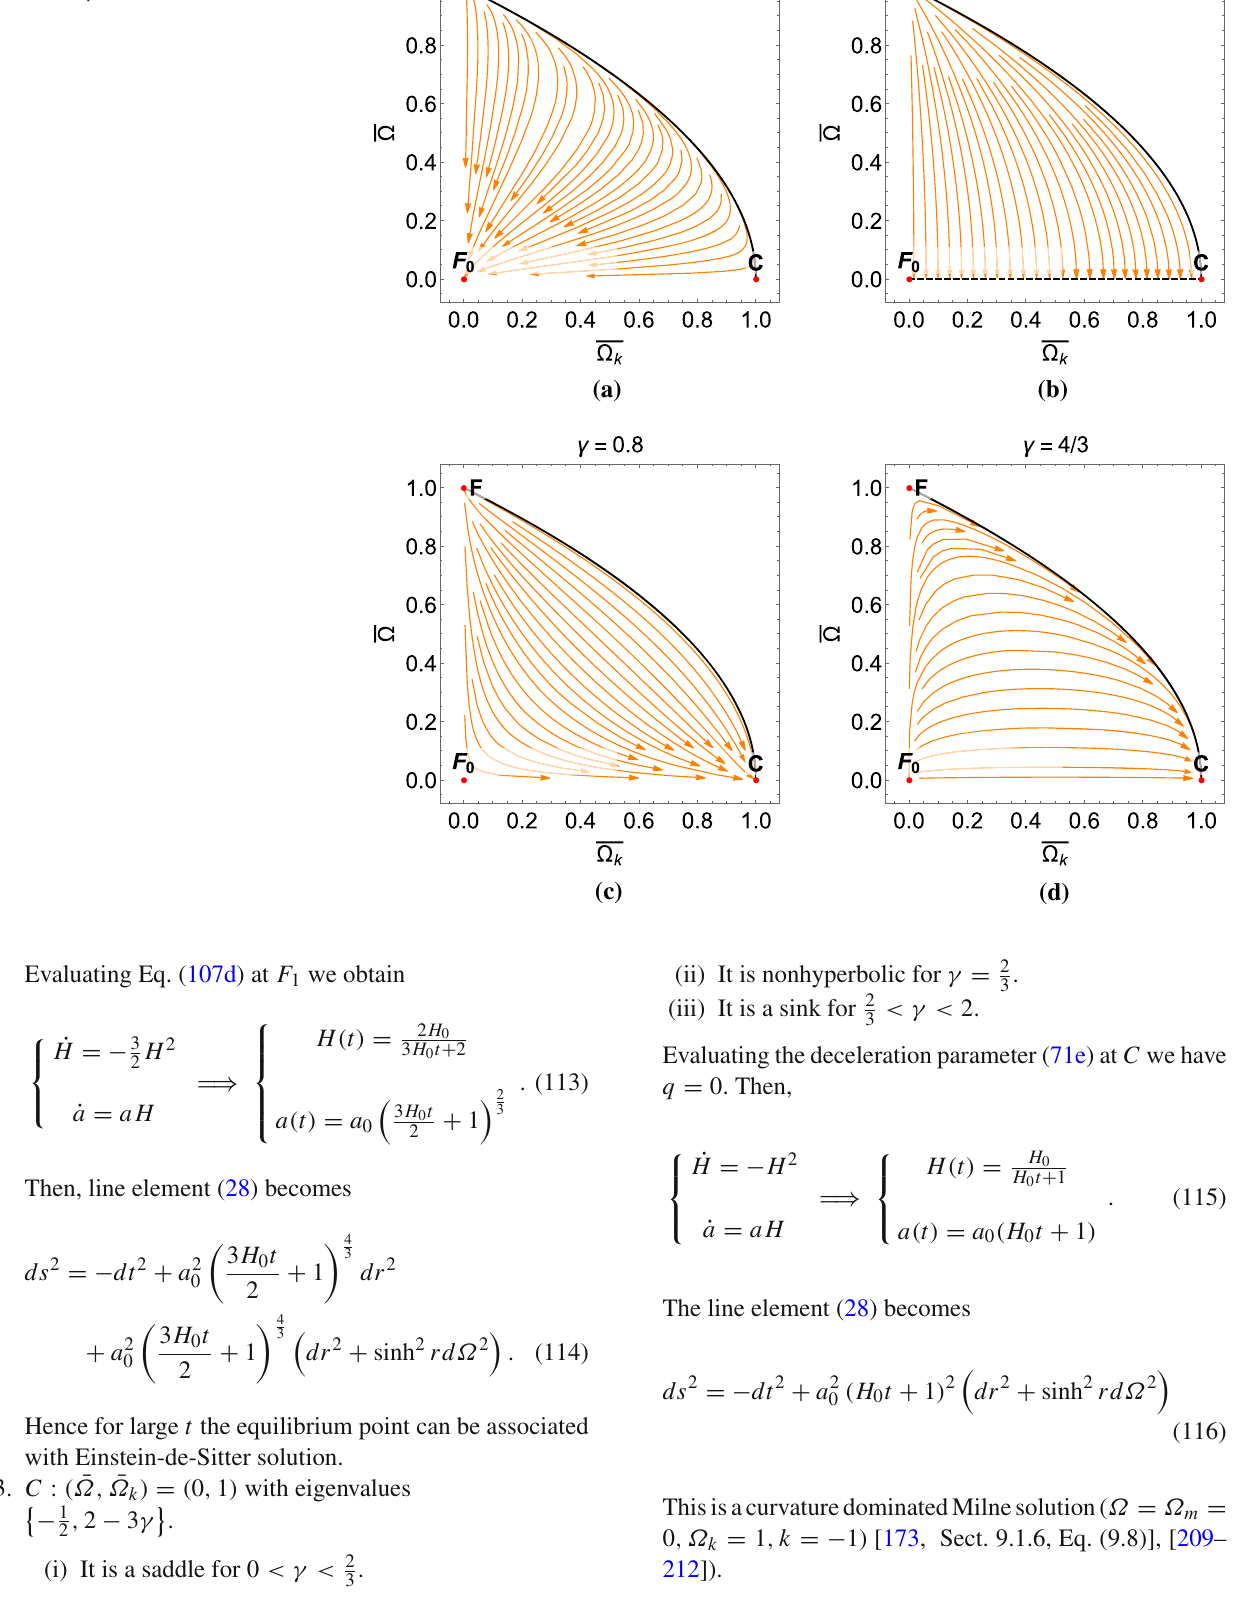
Fig. 7 Phase plane for system (107a), (107b) for different choices of